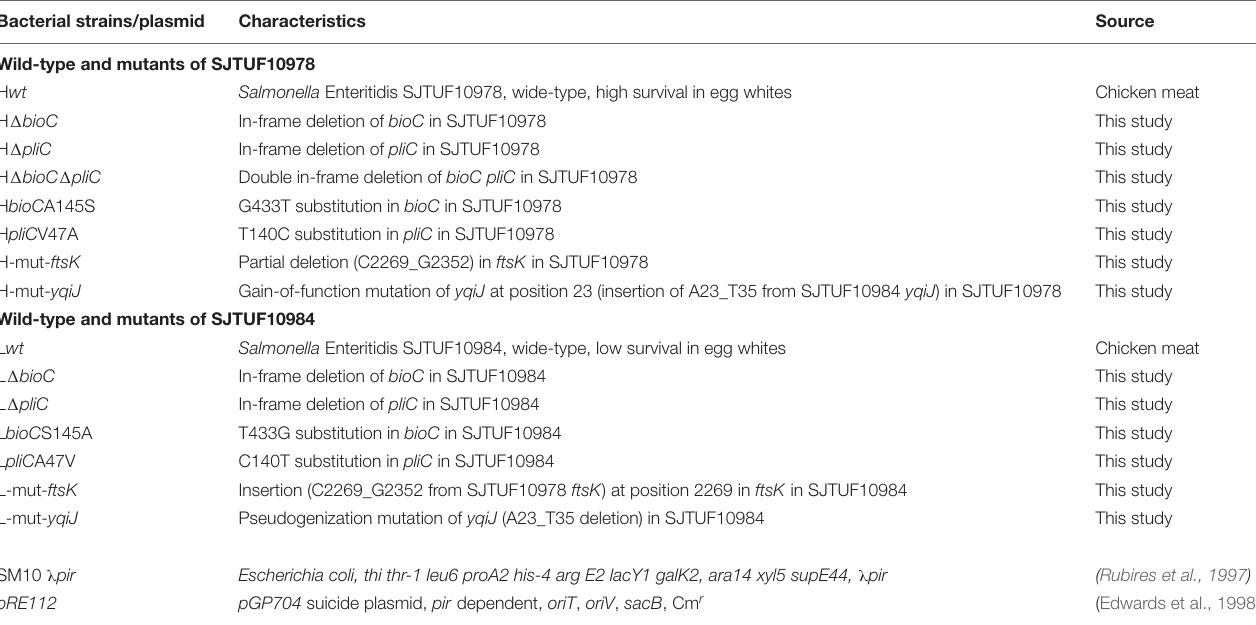
TABLE 3 | Bacterial strains and plasmids used for mutant